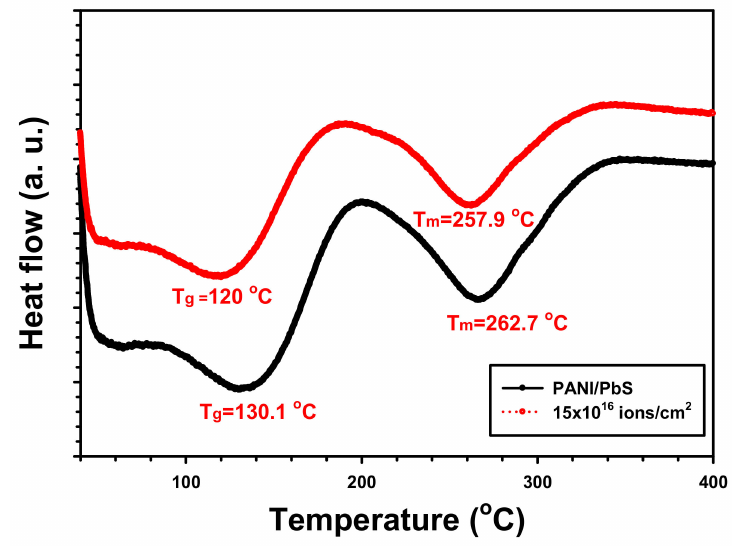
Figure 3. DSC thermograms of pure and irradiated